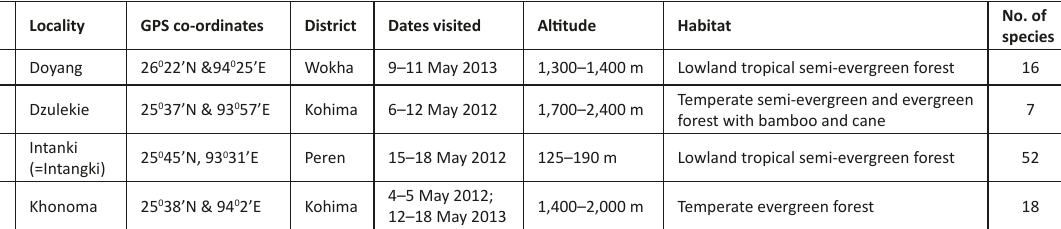
Table 1. Details of the survey localities in Nagaland.